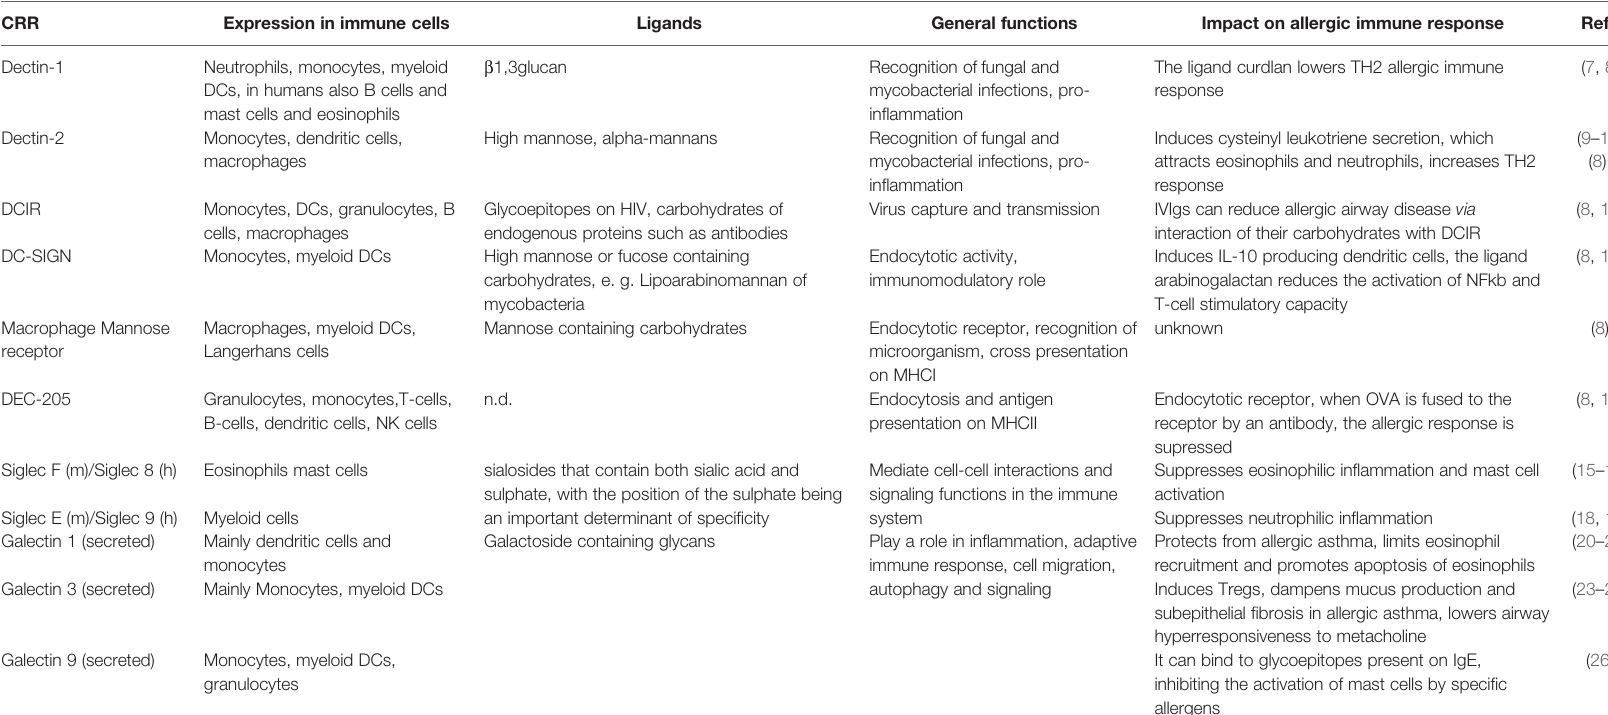
TABLE 1 | Carbohydrate recognition receptors